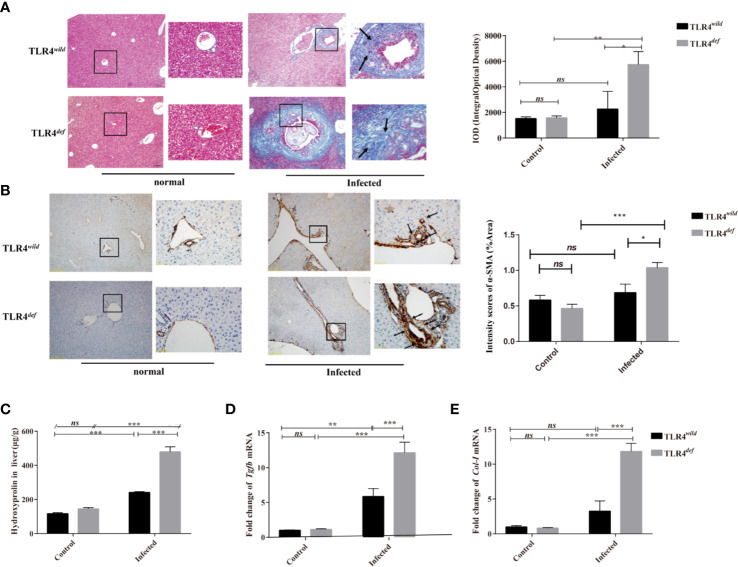
TLR4def led to an increased Clonorchis sinensis-caused pathogen-associated liver fibrosis in C57BL/10 mice. (A) Masson’s staining showed collagen depositions of the liver in TLR4wild and TLR4def mice infected with C. sinensis under 100× and 400× microscope. The integral optical density (IOD) of collagen fibers indicated by Masson’s trichrome staining was digitized and quantitated in the liver of non-infected and infected mice by on Image-Pro Plus software. (B) The expression of α-SMA of the liver in mice infected with C. sinensis under 100× and 400× microscope. Arrow indicates the positive cells. The positive areas in the liver of non-infected and infected mice were quantitated by Image J. (C) Detection of hydroxyproline in mice liver after C. sinensis infection. (D, E) Fold expression of fibrotic related molecules in Tgfb
(D), Col1a
(E) in the liver of mice infected with C. sinensis. The values were expressed as mean ± SEM. Compared with indicated groups, *P < 0.05, **P < 0.01, ***P < 0.001.